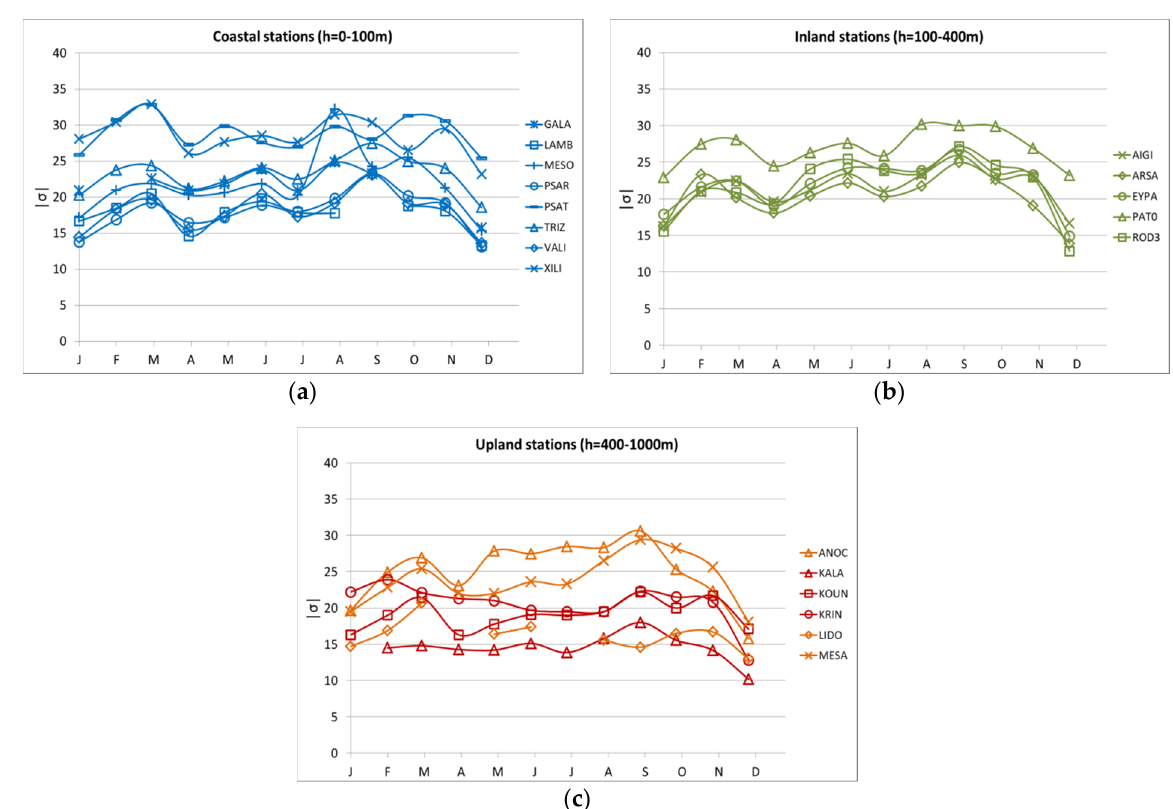
Figure 12. Monthly variability of MAB at the 19 PaTrop stations, classified per terrain type: coastal ( a ); inland ( b ); upland (red = north, orange = south) ( c ).